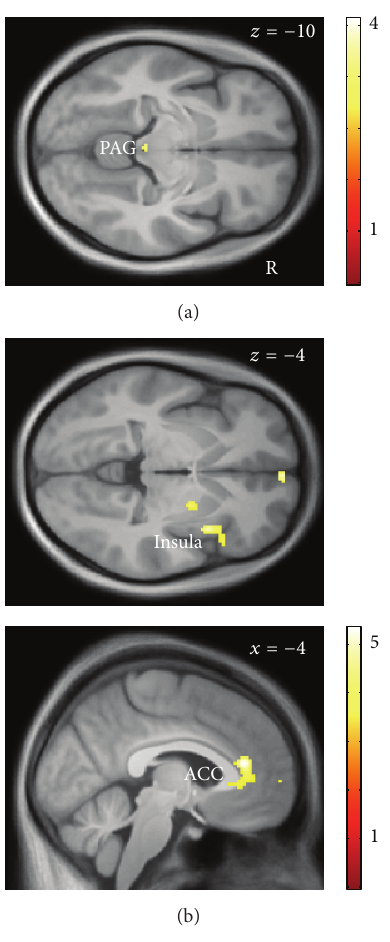
Figure 5: (a) Backward model: right insular activation during dyspnea perception is significantly correlated with midbrain/PAG activation during dyspnea anticipation ( 𝑥 = −2 , 𝑦 = −30 , 𝑧 = −10 ; ROI-corrected 𝑝 = 0.026 ). (b) Anticipatory fear is significantly correlated with increased brain activation during dyspnea anticipation in the ACC ( 𝑥 = −4 , 𝑦 = 36 , 𝑧 = 14 ; ROI- corrected 𝑝 = 0.001 ) and right insular cortex ( 𝑥 = 38 , 𝑦 = 12 , 𝑧 = −4 ; ROI-corrected 𝑝 = 0.007 ). The nonsignificant correlations with the putamen and medial prefrontal cortex (b) were outside our ROIs and did not reach whole-brain-corrected significance. All correlations are displayed at a threshold of 𝑝 < 0.05 , corrected for the specific ROI, and superimposed on the group-specific T1- weighted mean image generated by the